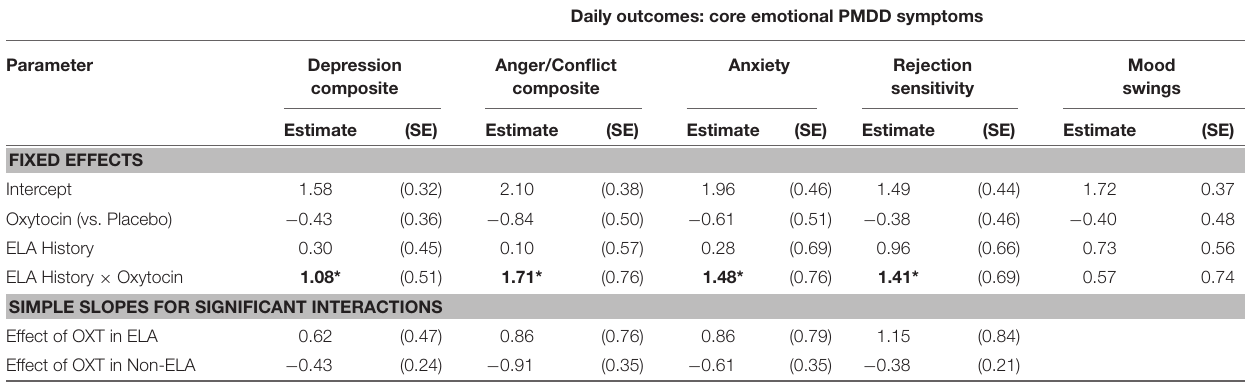
TABLE 2 | Fixed effects of ELA, oxytocin (vs. placebo), and their interactions on luteal PMDD symptoms on insufflation days.